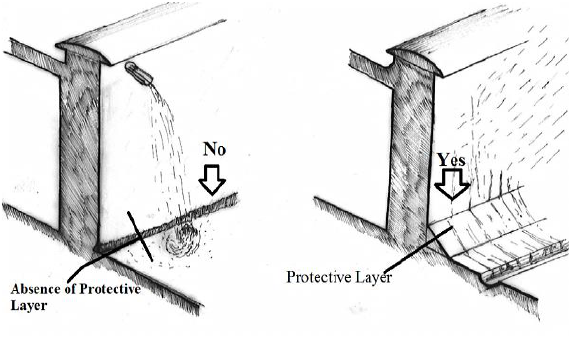
Figure 7. Protective layer.